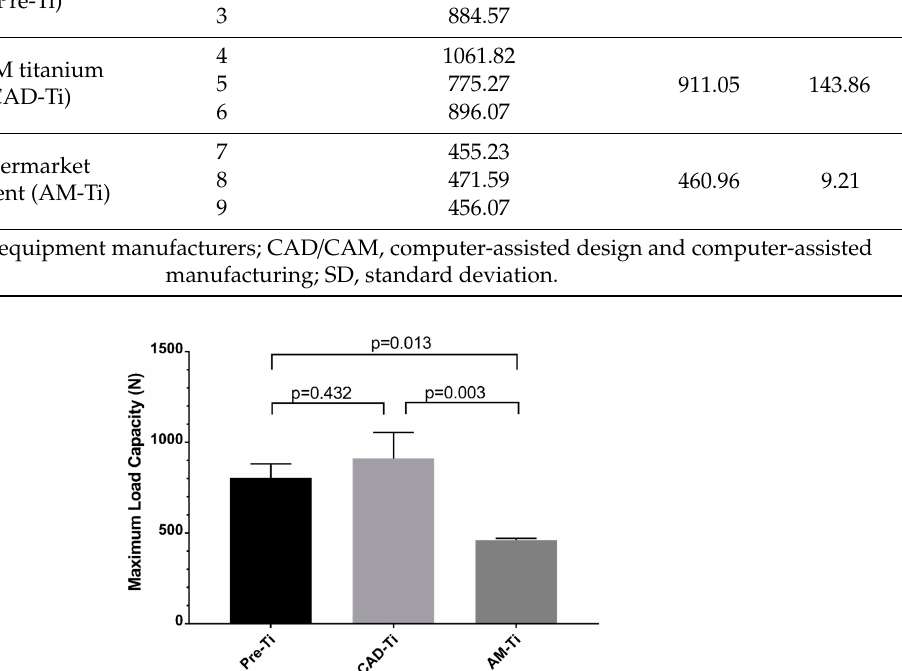
Table 1. Maximum load capacity of titanium abutments (n = 3) .